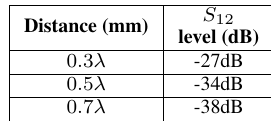
TABLE 2. Mutual Coupling Comparison 8 Antipodal Vivaldi Antenna at 5.8 GHz